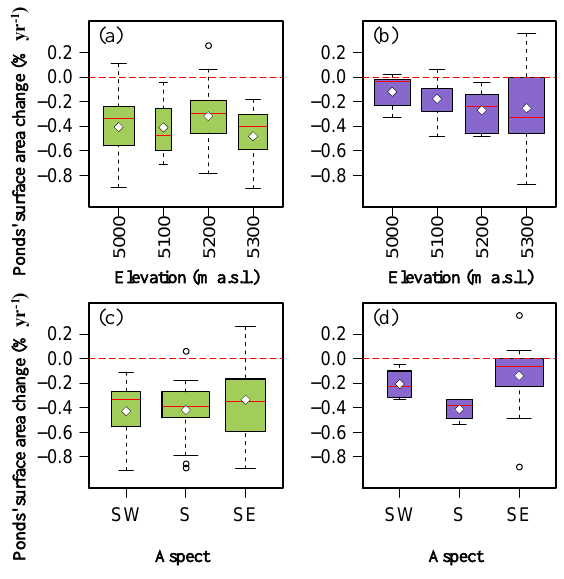
Figure 7. Pond surface area changes observed during the 1992– 2013 period in relation to certain morphological boundary con- ditions in the basin: elevation (upper graphs) and aspect (lower graphs). On the left, ponds without glaciers are shown, and on the right, ponds with glaciers. The white points in the box plots indicate the mean, whereas the red lines indicate the